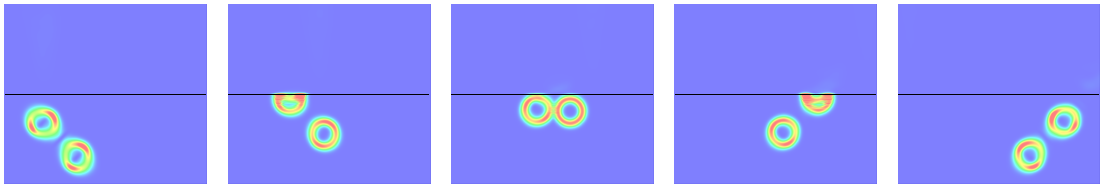
Figure 11. Reflection of a toroidal-vortex at the interface of (cid:101) 2 / (cid:101) 1 = 0.40 with the incident angle of 45 ◦ .